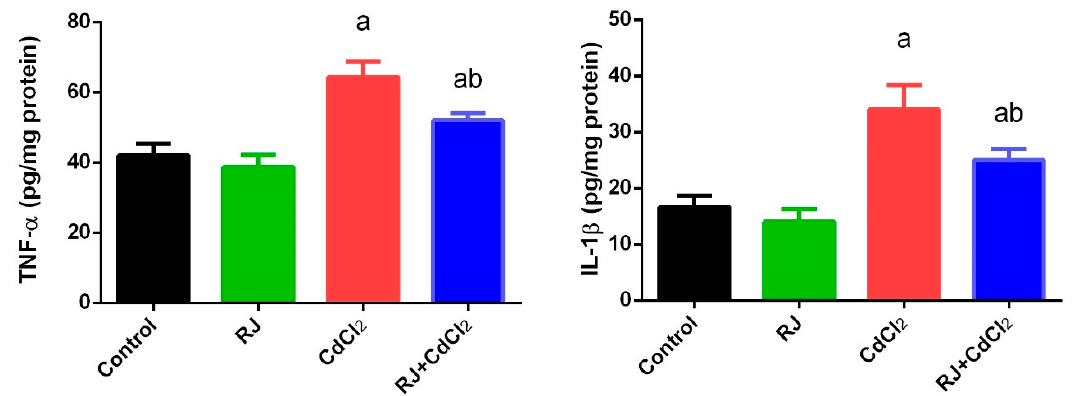
Figure 7. Effects of royal jelly (RJ) on the levels of tumor necrosis factor- α (TNF- α ) and interleukin 1 β (IL-1 β ) in testes of mice exposed to cadmium chloride (CdCl 2 ). All values are expressed as mean ± SEM (n = 7). a refers to a significant change from the control mice at p < 0.05; b refers to a significant change from the CdCl 2 - treated mice at p < 0.05, using Duncan’s post hoc test.